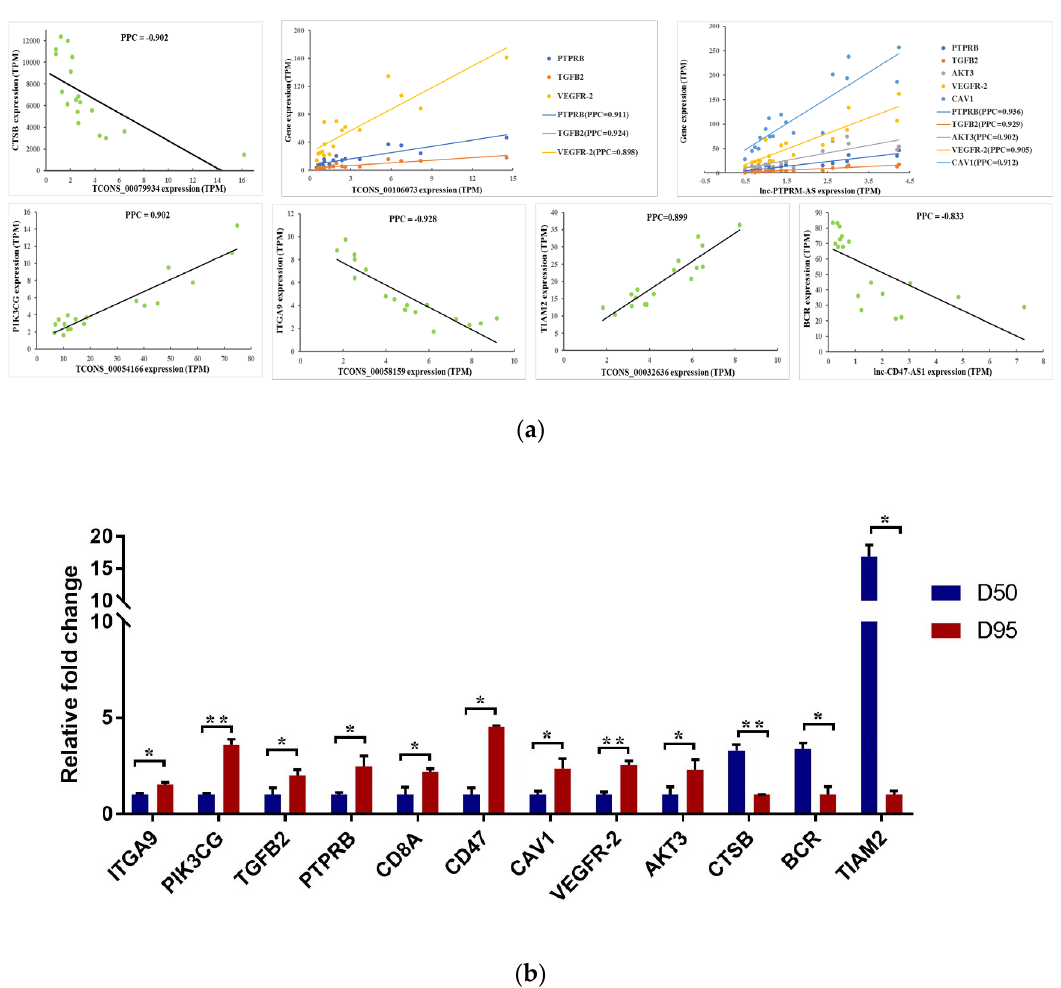
Figure 4. Validation of the expression pattern of the DEgenes co-expressed with the H3K4me3- and/or H3K27ac-modified DElncRNAs. ( A ). A scatterplot of the DElncRNAs and co-expression genes’ expression levels in individual placental samples determined by RNA-Seq. ( B ). Quantitative RT-PCR validation of the DEgenes co-expressed with the DElncRNAs. PCC, Pearson correlation coefficient; data are represented as mean + SEM, n = 3. * p < 0.05; * p <